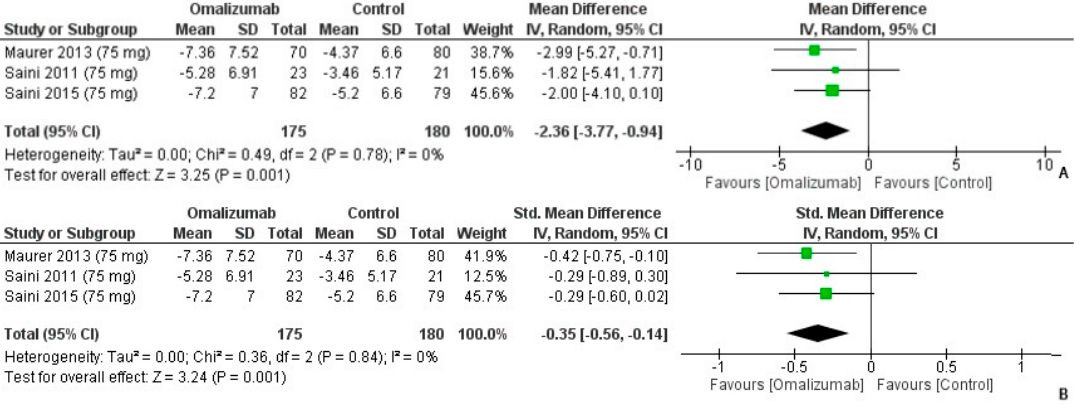
Figure 5. Weekly Wheal Score Outcomes with 75 mg dosage of omalizumab [18,19,23]. ( A ): Mean difference: − 2.36 [95% CI: − 3.77, − 0.94]; Heterogeneity: Tau² = 0.00; Chi² = 0.49, df = 2 ( p = 0.78); I² = 0%; Test for overall effect: Z = 3.25 ( p = 0.001). ( B ): Standardized mean difference: − 0.35 [95% CI: − 0.56, − 0.14]; Heterogeneity: Tau² = 0.00; Chi² = 0.36, df = 2 ( p = 0.84); I² = 0%; Test for overall effect: Z = 3.24 ( p = 0.001).